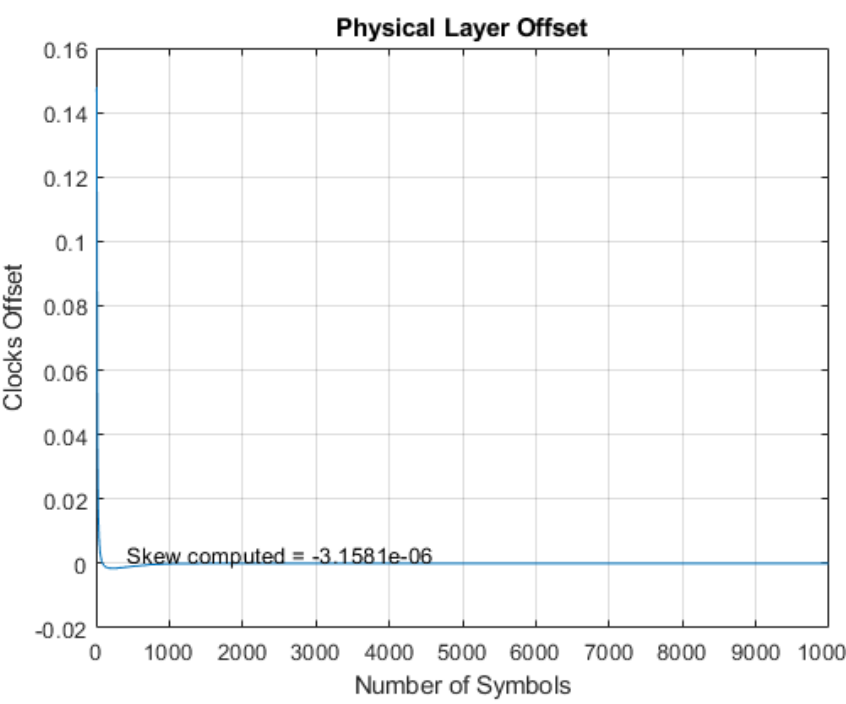
Figure 10. Computation of skew offset using the LS